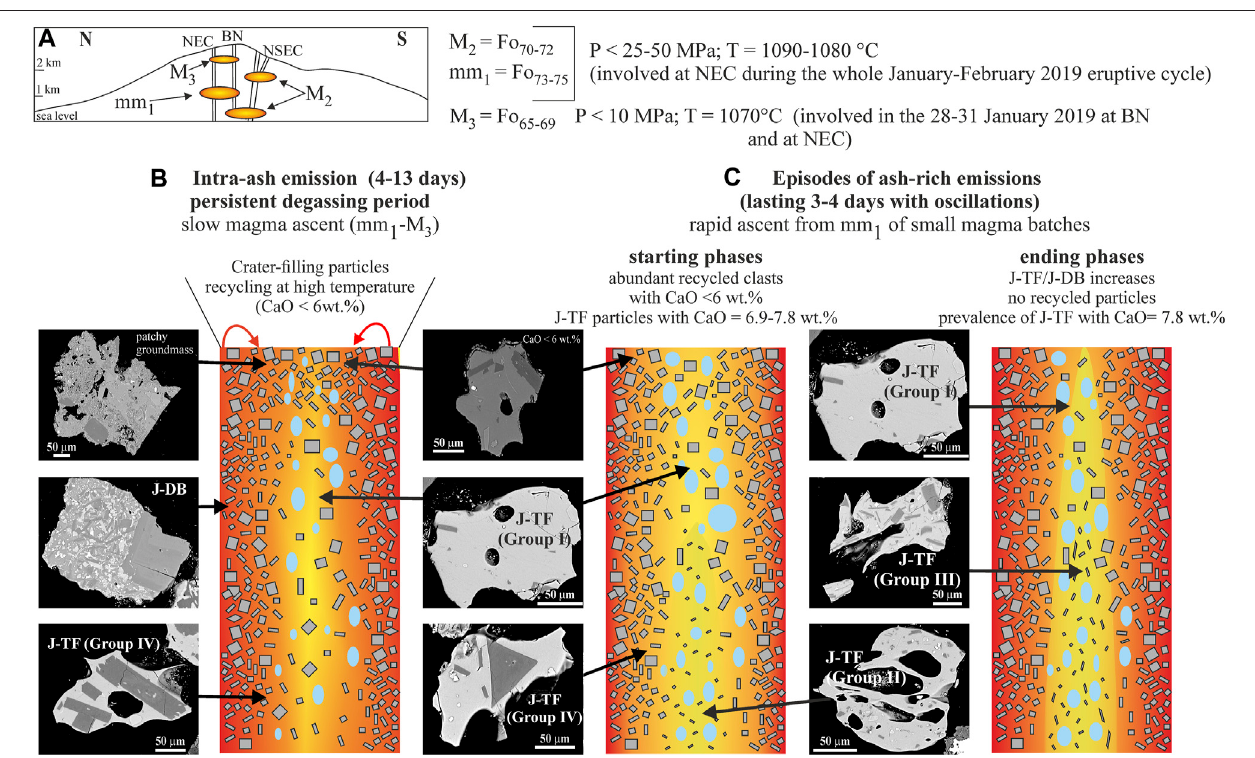
FIGURE 12 | Schematic view of the syn-eruptive processes acting during the January – February 2019 ash-emission cycle at Mt. Etna. In the upper part of the sketch, (A) theshallowplumbingsystematMt.EtnaispresentedwiththeindicationsofP-Tconditions(modi fi edafterKahletal.,2015).NandScorrespondtoNorthand South, respectively. (B) Period ofintra-ash emission characterized by persistent degassingand slow magma ascent (mm 1 -M 3 ) recorded in the groundmass texture and compositionofjuvenileTFclastsfromtexturalGroupI(centralportionoftheconduit)andIV(lateralportionoftheconduit)andJ-DBparticles(conduitwallsmargin). Particles recycled under high temperature and oxidizing conditions from previous explosions fi ll the crater area, reducing the permeability, enhancing stiffness of the top ofmagmacolumn,andcontributingtothe fi neashgeneration. (C) Ash-emissionactivitywasdrivenbytheascentofsmallbatchesofrelativedeepermagmas,associated with Group II in the starting phases of each episode and with Group III toward the ending phases, respectively. The conduit color, from yellow to red, corresponds to a decreasing in magma temperature.